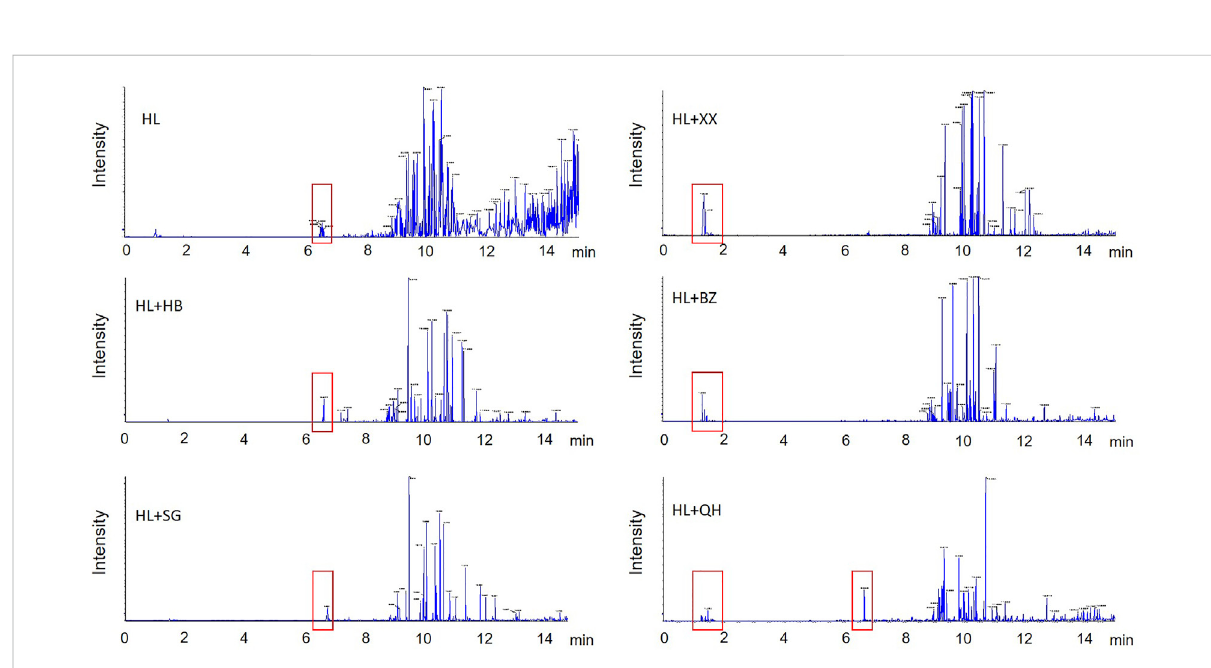
FIGURE 9 The secondary ion mass spectrogram of the heat-clearing and exterior-releasing TCM pairs by UPLC-QTOF/MS analysis. HL, Coptis chinensis ; HB, Phellodendron chinense , SG, Gypsum Fibrosum, XX, Asari radix et rhizoma , BZ, Angelicae dahuricae radix , QH, Notopterygii rhizoma et radix